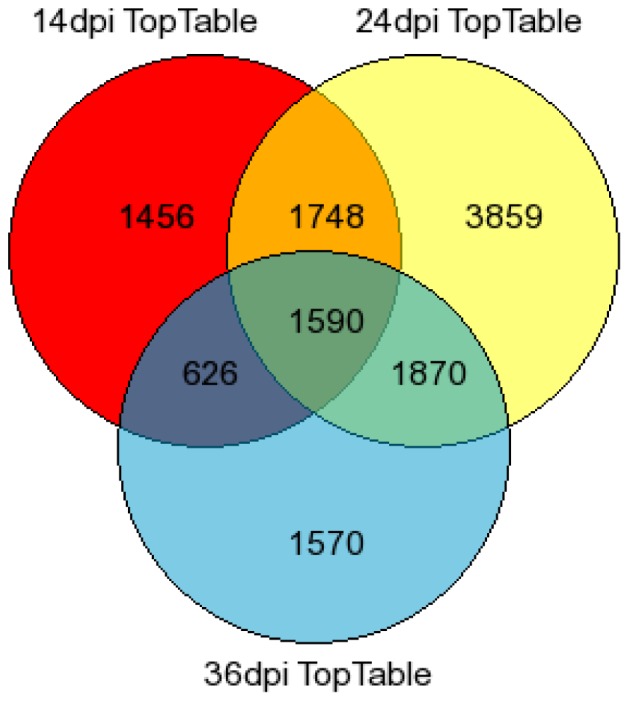
Venn diagram depicting the distribution of 13,934 differentially expressed genes (p<0.05) in SACMV - infected leaf tissue at three time points post infection.